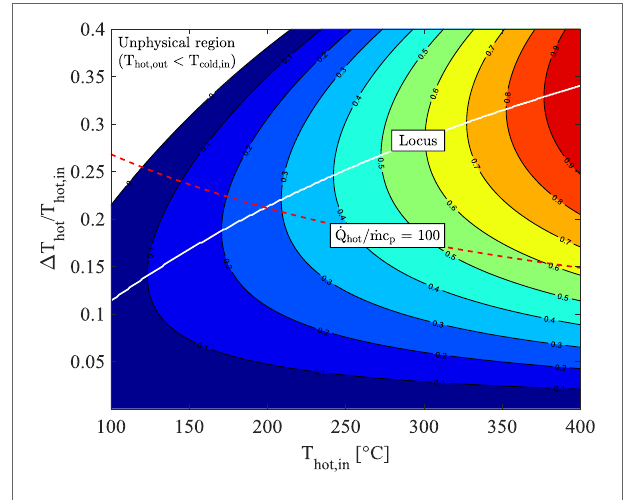
= showing locus of maximum net output power, cold with T cold,in = 20°C